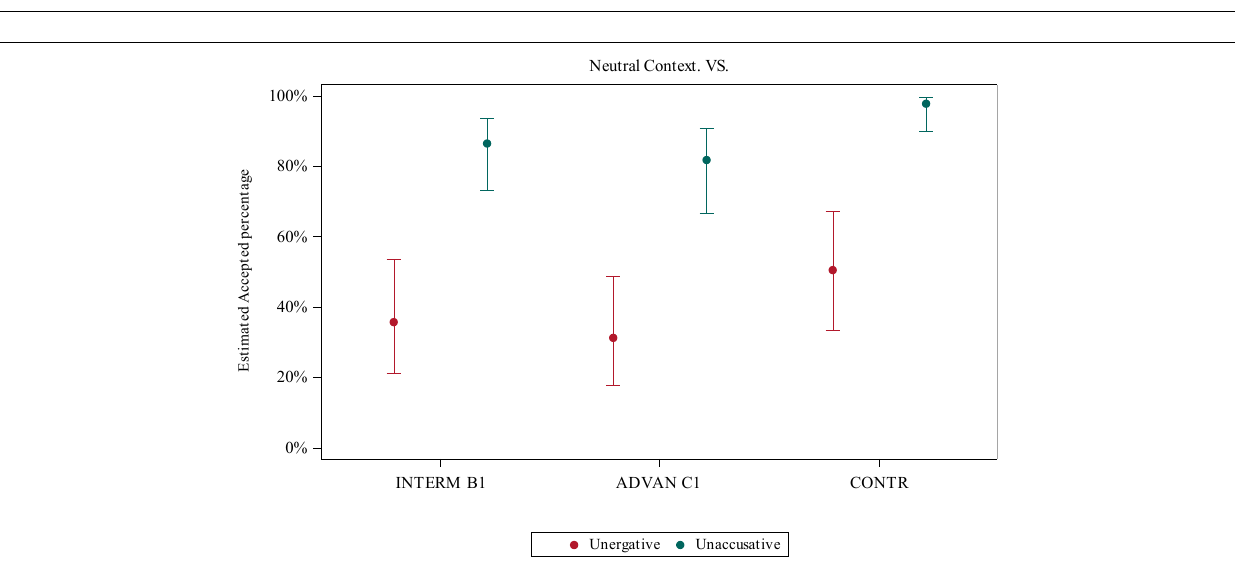
FIGURE 2 | Estimated acceptance percentage for the SV condition in neutral contexts according to Verb Class.